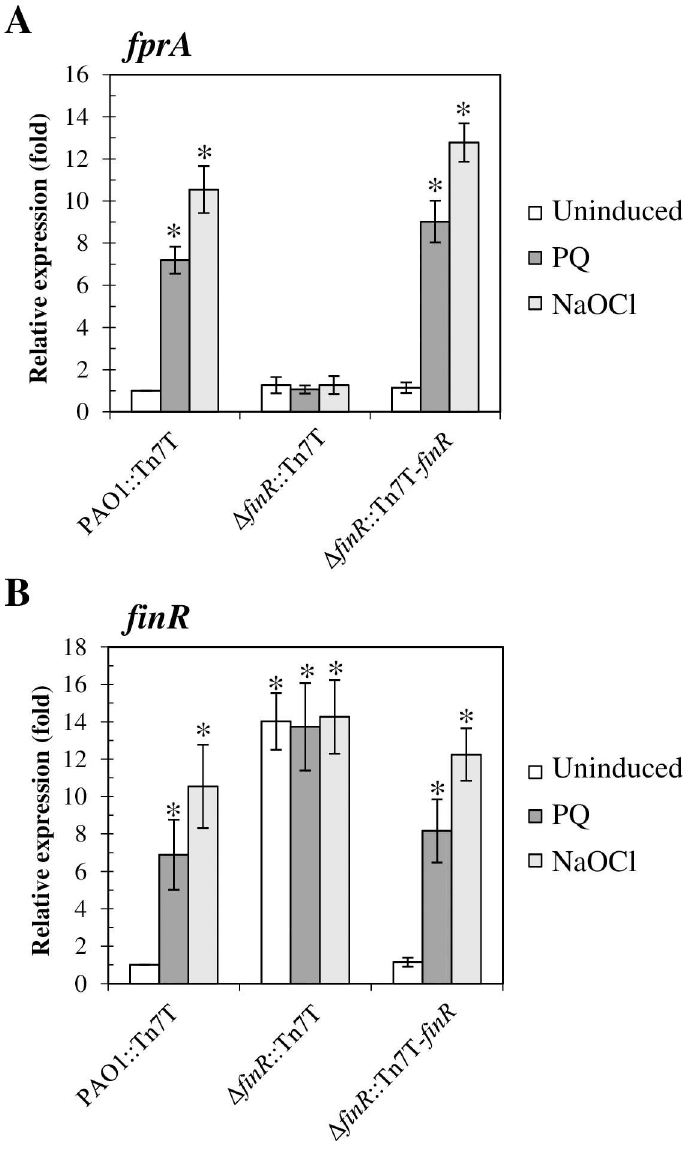
Fig 3. Expression analysis of fprA and finR in P . aeruginosa strains. Expression levels of fprA (A) and finR (B) in PAO1 wild type (PAO1::Tn7T), Δ finR mutant ( Δ finR ::Tn7T) and the complemented mutant ( Δ finR :: Tn7T- finR ) grown under uninduced,0.5 mM paraquat (PQ), or 0.04% NaOCl (NaOCl) inducedconditions. Relativeexpressionwas analyzedusing the 16S rRNA gene as the normalizing geneand is expressedas fold expression relativeto the level of uninduced PAO1. Data shownare means ± SD of three independent experiments. The asterisks indicatestatistically significant differences (p < 0.01) comparedwith the uninduced